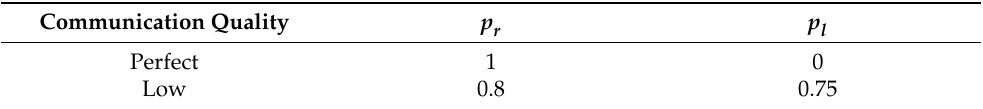
Table 2. Communication parametrization regarding the communication quality and the probability of burst